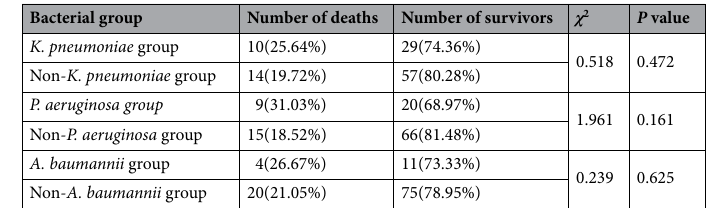
Table 5. Effects of the three most frequently detected bacteria in blood culture on in-hospital mortality of burn patients.